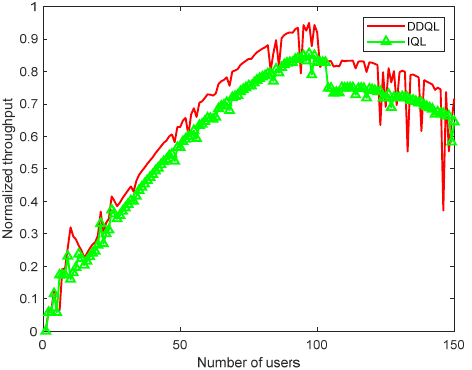
Figure 3. Normalized throughput versus number of users.